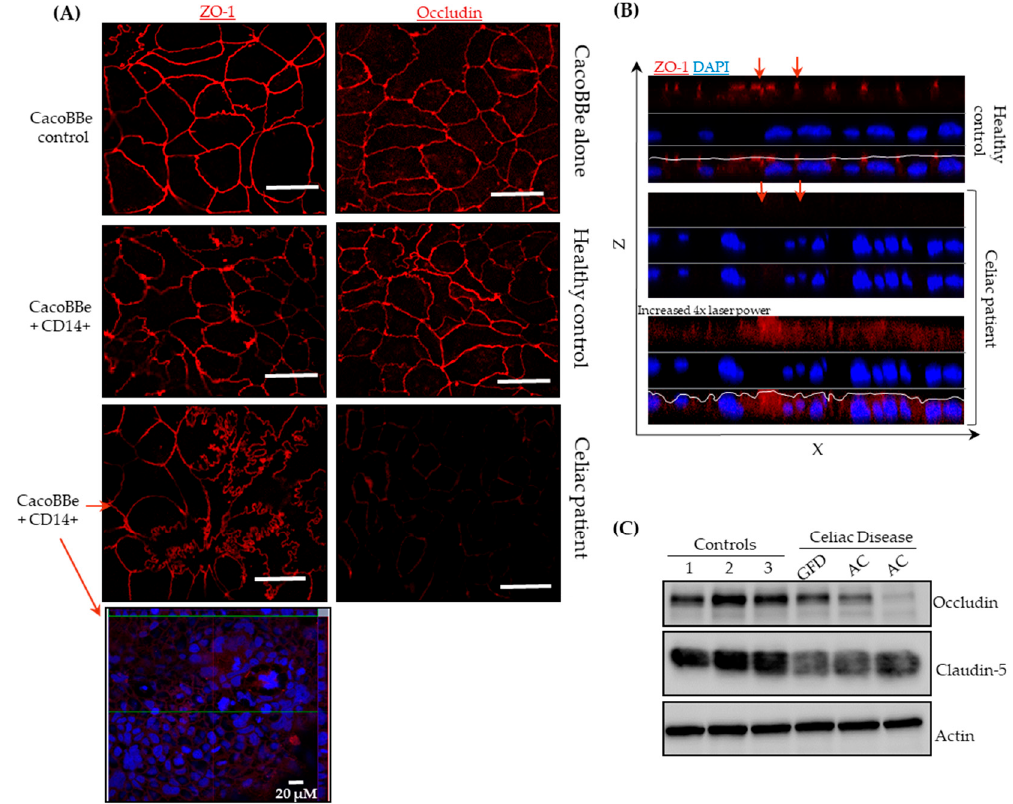
Figure 2. Tight junction (TJ) structure and protein composition after co-culture with monocytes derived from celiac disease patients. ( A ) Cellular localization of occludin and ZO-1 were investigated using confocal laser scanning microscopy after immunostaining. Representative images from n = 5 (healthy donors), n = 3 (CeD on GFD) and n = 3 (Active CeD patients). Scale bar: 50 µM. The two effects of CD14 co-culture in ZO-1 expression is pointed out by red arrows ( B ) Collapsed XZ-projections. ZO-1 staining reveals apical junctional complexes at approx. identical Z heights, as illustrated by the white lining in the merged image. When CacoBBe cells co-cultured with celiac monocytes were immunostained, lining was comparably irregular, and ZO-1 level was reduced. ( C ) IEC protein levels by Western blotting of occludin and claudin-5 after co-culture with monocytes. 2.3. Monocytes Derived from Celiac Disease Patients Present Higher Levels of Proinflammatory Cytokine